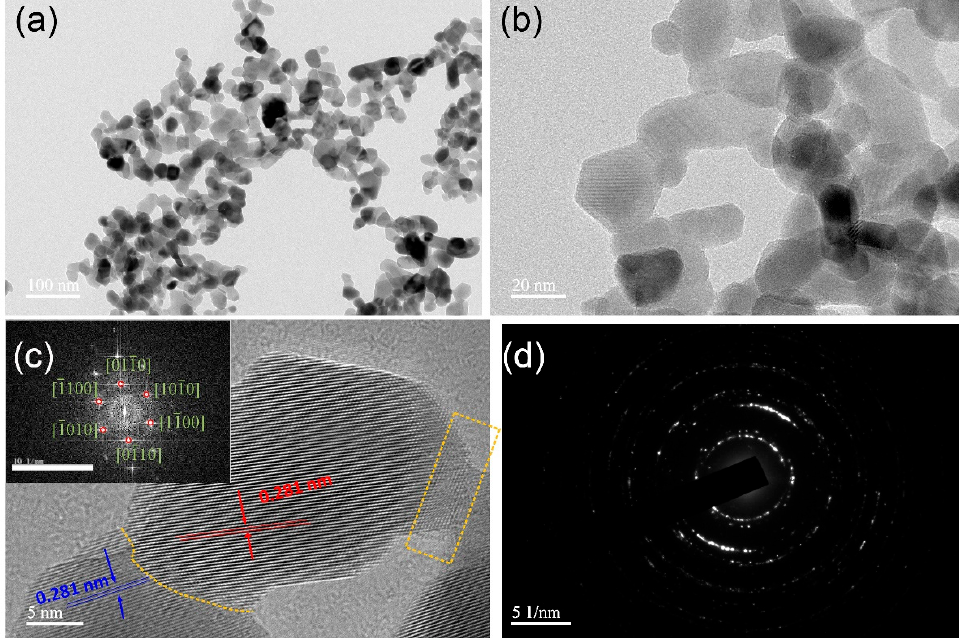
Figure 4. ( a ), ( b ) Low-magnification TEM images, ( c ) high-resolution TEM image, and ( d ) selected area electron diffraction pattern of hierarchical ZnO microspheres prepared at an annealing temperature of 400 °C. The inset in ( c ) shows the corresponding Fourier transform of the HRTEM image.